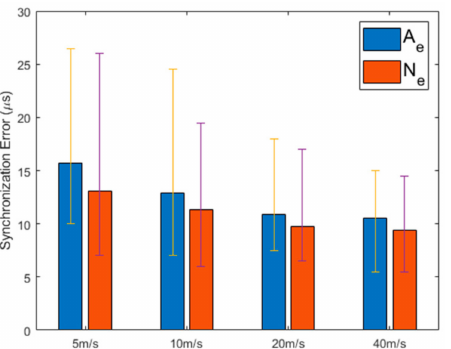
Figure 10. Synchronization error with varying node speed in mobile